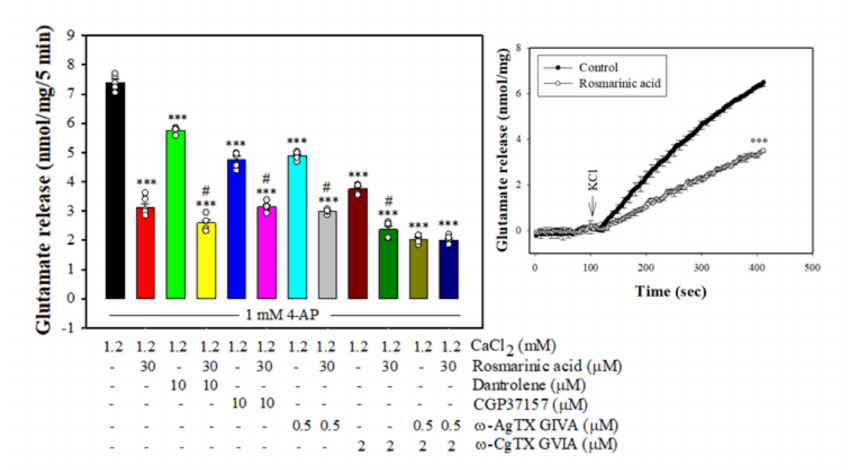
Figure 2. Effect of rosmarinic acid on 4-AP-evoked glutamate release in the presence of N-type Ca 2+ channel blocker ω -CgTX GVIA, P/Q-type Ca 2+ channel blocker ω -AgTX IVA, ryanodine receptor inhibitor dantrolene, or mitochondrial Na + /Ca 2+ exchanger inhibitor CGP37157. Inset, the inhibitory